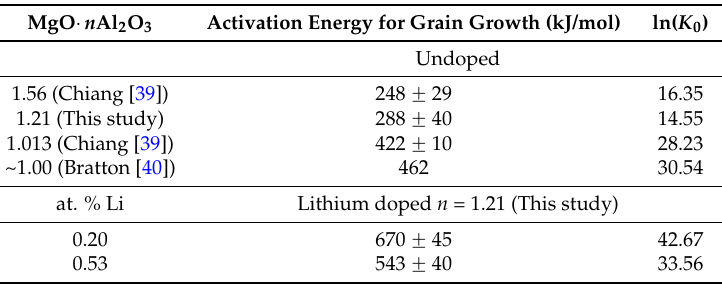
Table 3. Grain growth parameters for 0–0.53 at. % Li-MgO·1.21Al 2 O 3 .